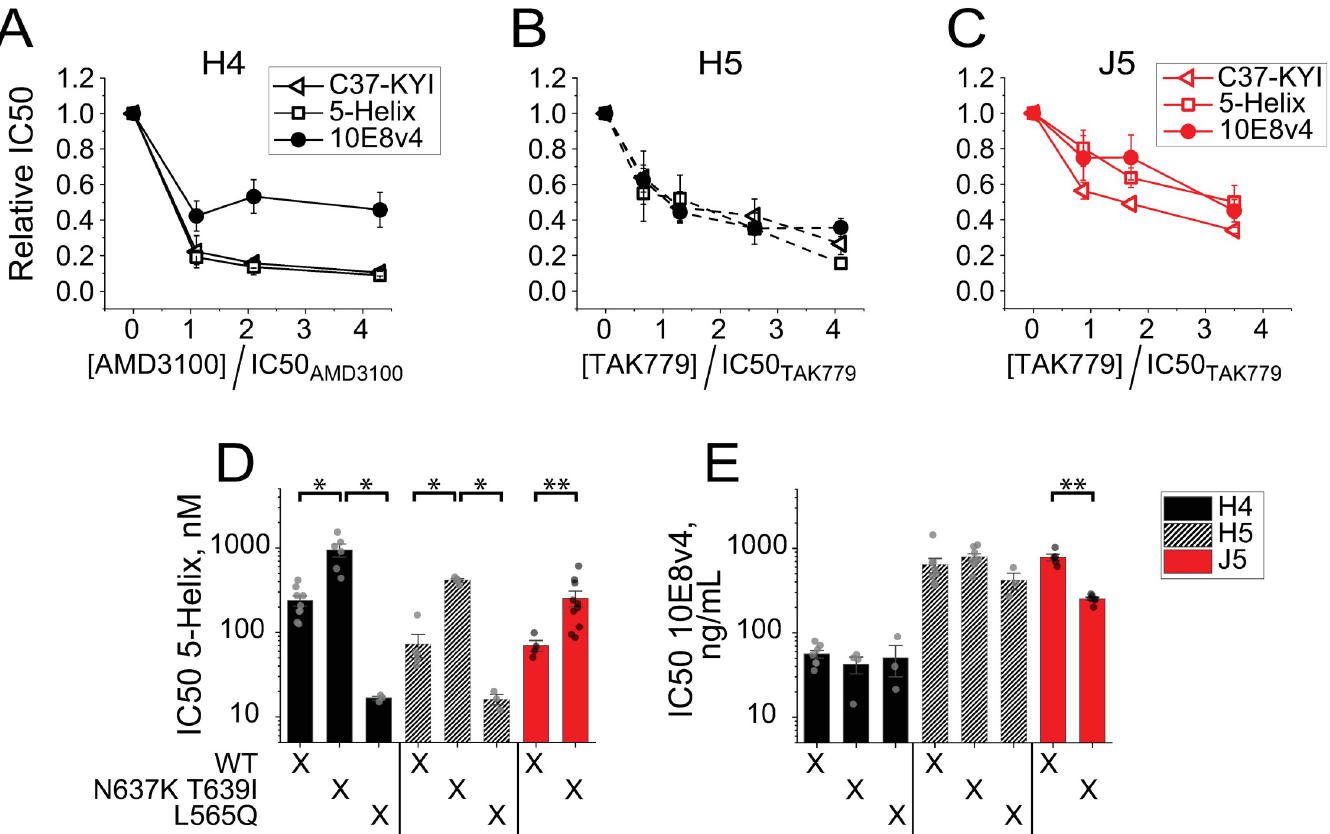
Fig 2. The V3-loop swap alters the temporospatial exposure of the MPER epitope in Env HXB2 . ( A-C ) Impact of CoR antagonism on the potencies of gp41-targeted inhibitors against HIV-1 pseudotyped with H4 Env ( A ), H5 Env ( B ) or J5 Env ( C ). IC50 values for C37-KYI (open triangles), 5-Helix (open squares) and NAb 10E8v4 (filled circles) were determined in the presence of either AMD3100 ( A ) or TAK-779 ( B, C ). Data have been normalized to the IC50 levels obtained in the absence of CoRA. Note that CoRA concentration is expressed relative to the CoRA IC50 for each virus (94, 61 and 23 nM for H4, H5 and J5 Envs, respectively). Data points represent the mean ± SEM of four independent experiments. For H4 Env, the NAb 10E8v4 data set is significantly different (p < 0.025) from the 5-Helix data set as determined by a two-way ANOVA; for the comparison of 10E8v4 and C37-KYI data sets, p = 0.029. No statistical difference was observed in any of the data set comparisons for H5 and J5 Envs. ( D, E ) Potencies of fusion inhibitor 5-Helix ( D ) and NAb 10E8v4 ( E ) against Envs with altered PHI lifetimes. IC50 values were determined against HIV-1 pseudotyped with H4 Env (solid black), H5 Env (hatched black) and J5 Env (red) containing either the rate-enhancing N637K/T639I substitution or the rate-retarding L565Q substitution. Bars represent the mean ± SEM of three or more independent experiments. Single asterisks indicate significance as determined by one-way ANOVA with means comparisons using the Tukey method with p < 0.025 [109]; double asterisks indicate significance as determined by a two- sample t-test (equal variance not assumed) with p <